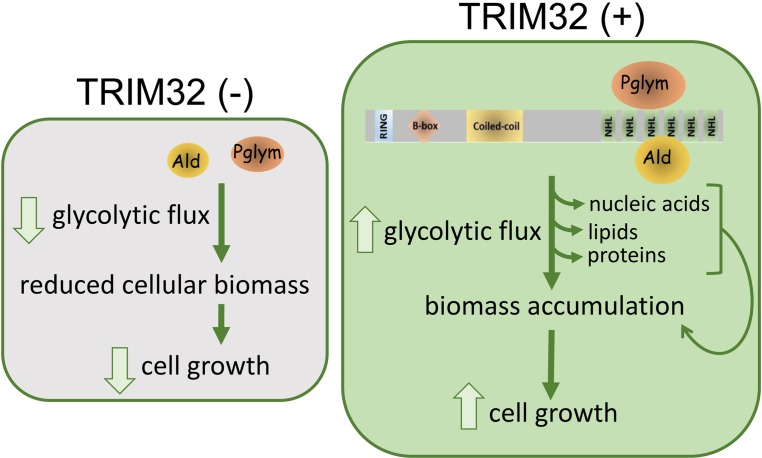
Model for TRIM32 function in the regulation of cell size.Biochemical interactions between TRIM32 and glycolytic enzymes such as Ald or Pglym cooperate in maintaining glycolytic activity for the synthesis of macromolecules required for cell growth. Loss of TRIM32 results in reduced levels of glycolytic enzymes, reduced glycolytic pathway intermediates, and compromises cell growth.